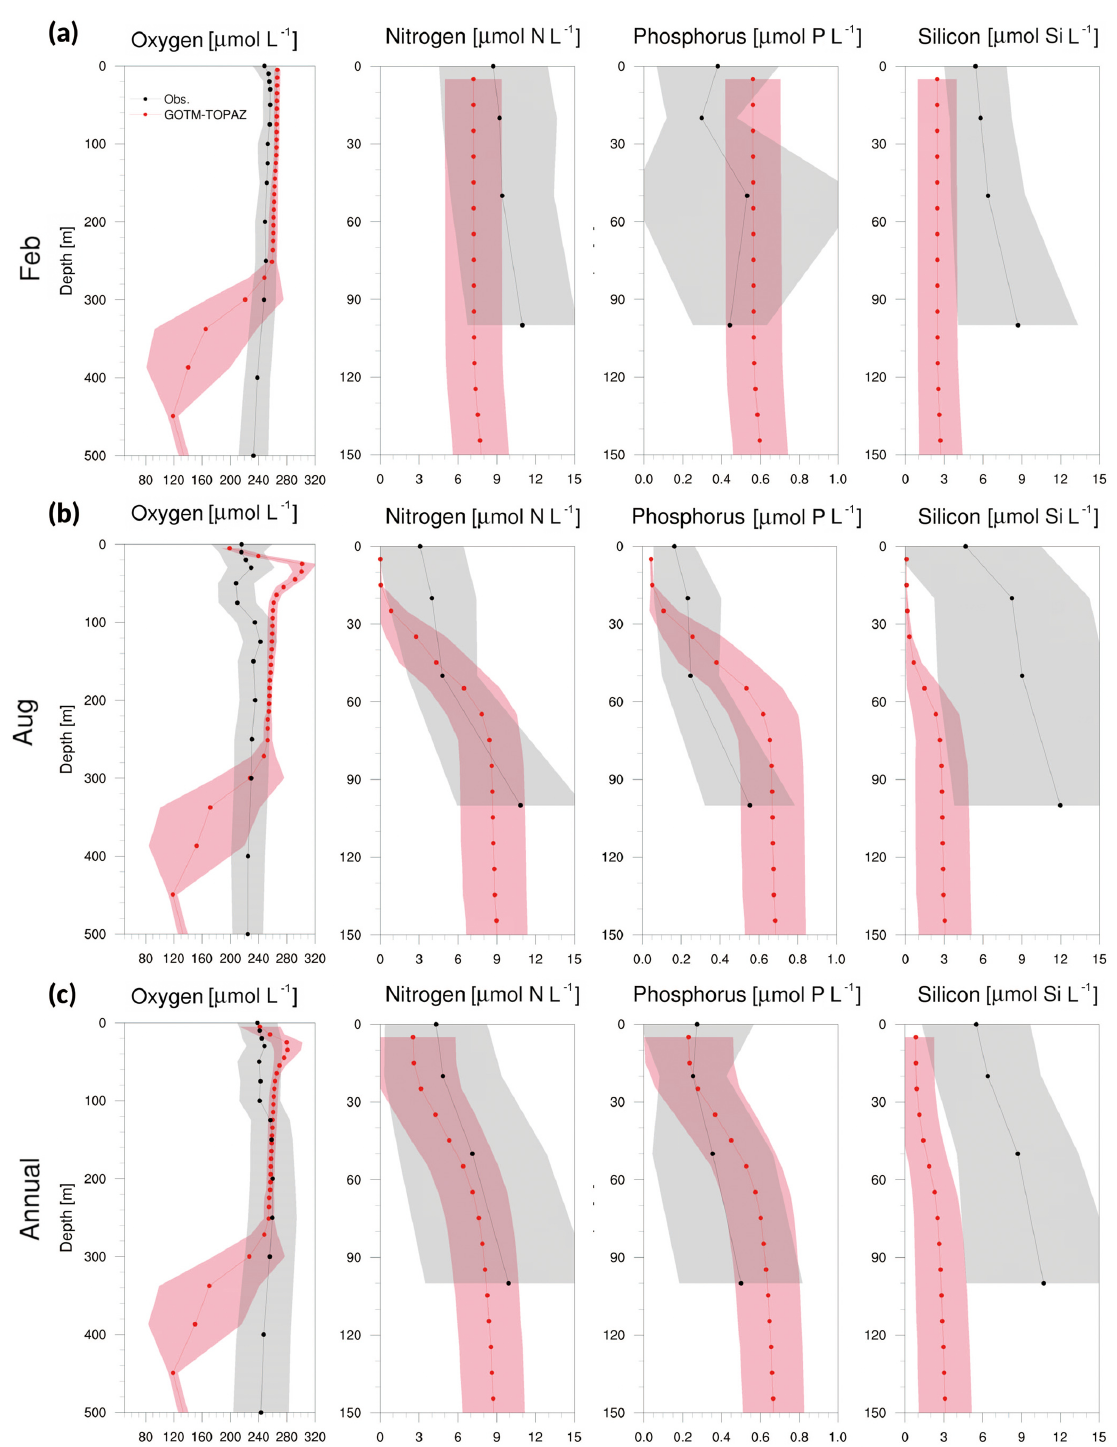
Figure 9. Vertical profiles from observational data (black dots) and GOTM–TOPAZ results (red dots) at point 104 for concentrations of dissolved oxygen, nitrogen, phosphorus, and silicon averaged from 1999 to 2008, (a) for February, (b) for August, and (c) annually. The shaded areas represent 1 σ . In this figure, nitrogen, phosphorus, and silicon include NO 3 , PO 4 , and SIO 4 ,